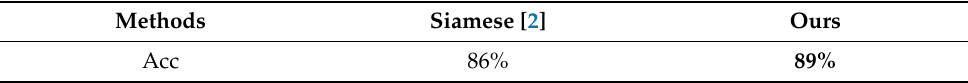
Table 6. Comparison of results on the Curtin Faces Table 5. Comparison of results achieved by different methods on the Pandora dataset.